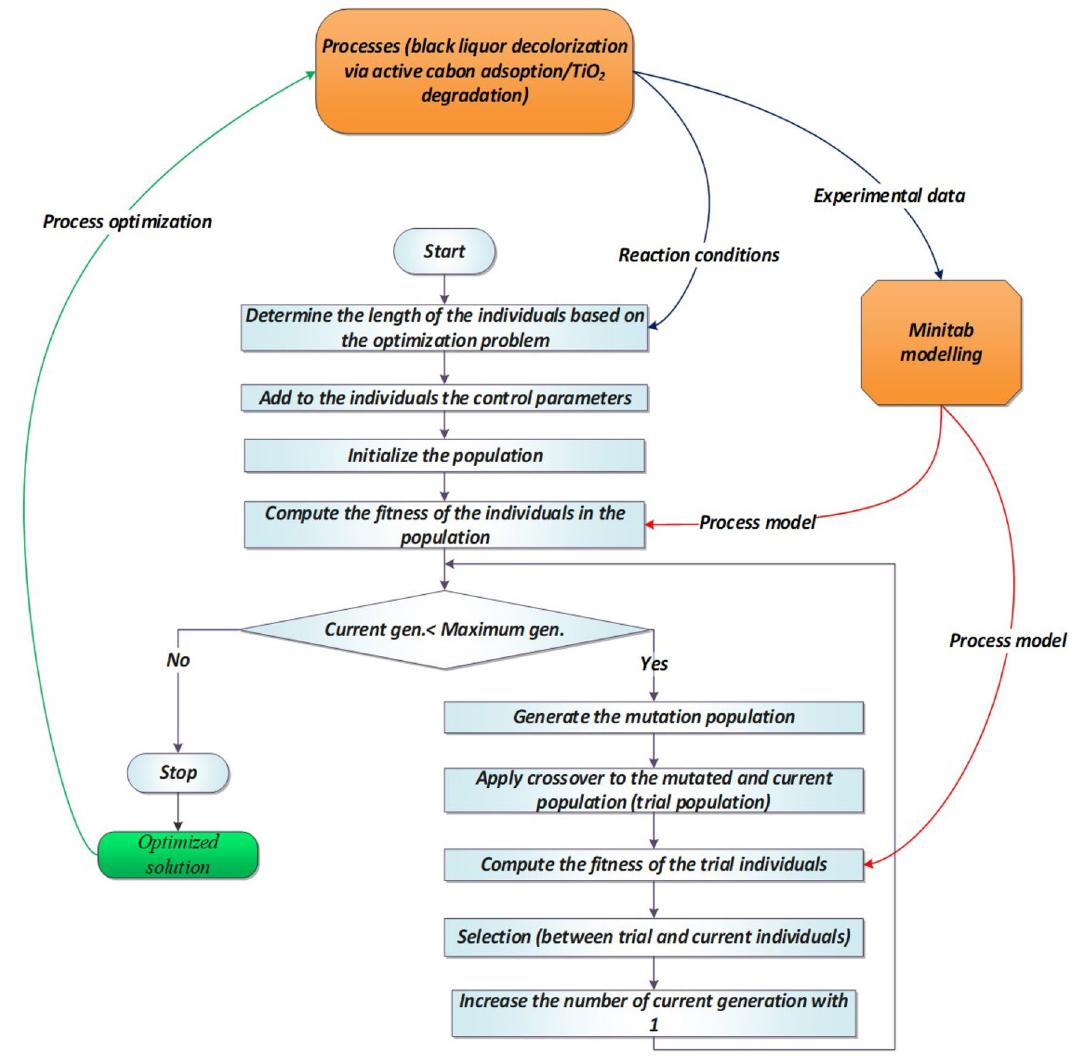
Figure 3. Scheme of the overall optimization